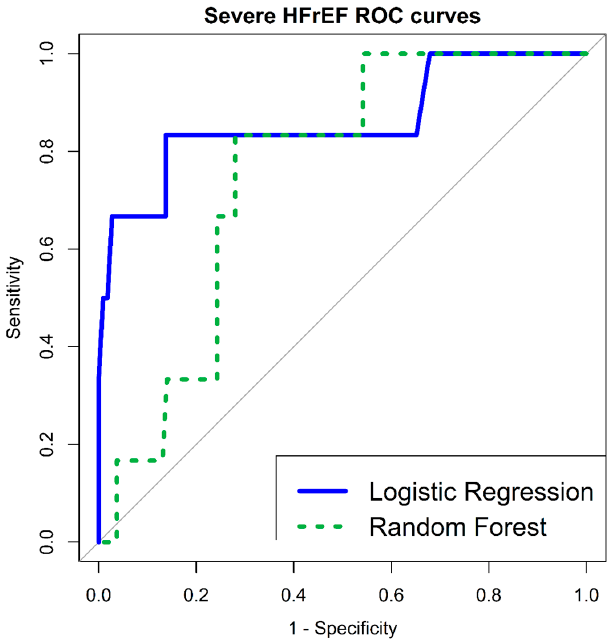
Figure 1. ROC curves—Severe HFrEF—multivariate LR and RF classification models. HFrEF—Heart Failure reduced Ejection Fraction; LR—Logistic Regression; RF—Random Forest; ROC—Receiver Operating Characteristic.